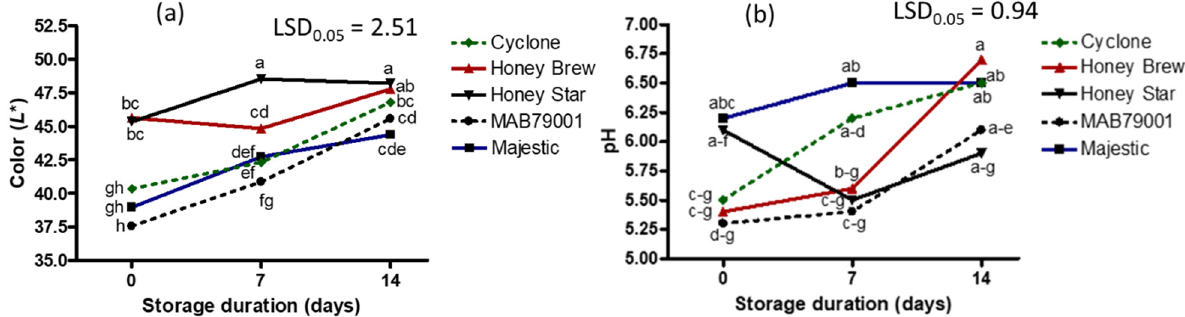
Figure 6. Effect of postharvest storage duration on sweet melon total soluble solids ( a ) and total phenolic content ( b ). Points on the line with different letters in each graph are significantly different at p ≤ 0.05 (Fisher’s protected LSD test, n = 3). GAE = gallic acid equivalent; DW = dry weight.